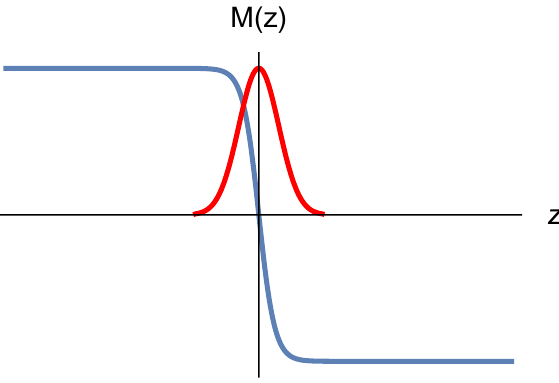
Figure 1 . Mass pro(cid:12)le M = M ( z ) (blue line) and wavefunction of the Hamiltonian zero mode (red